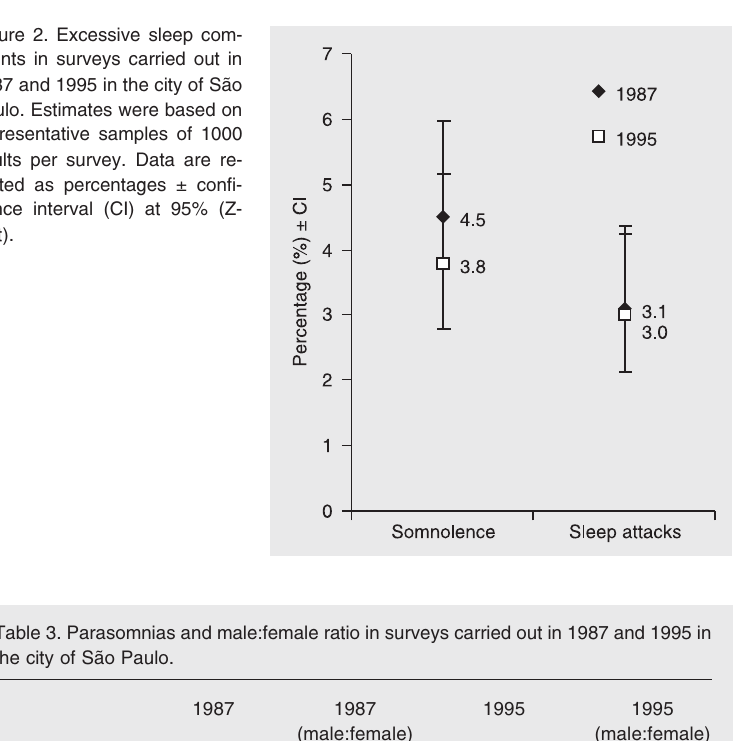
Figure 2. Excessive sleep com- plaints in surveys carried out in 1987 and 1995 in the city of São Paulo. Estimates were based on representative samples of 1000 adults per survey. Data are re- ported as percentages ± confi- dence interval (CI) at 95% (Z- test).